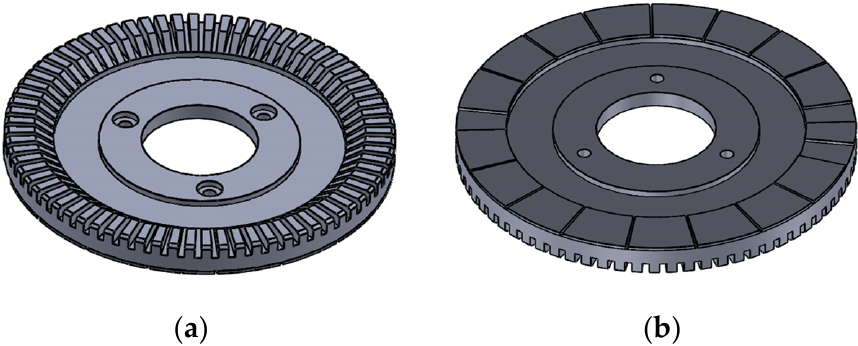
Figure 14. Piezoelectric stator model: ( a ) Stator front; ( b ) Stator back.